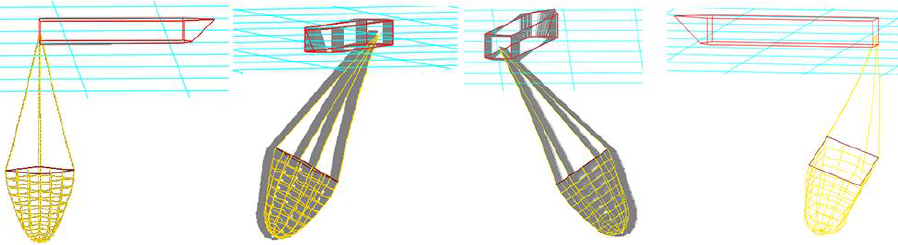
Figure 21. Shape changes of rigid truss trawl rotating towing under fixed turning radius at v = 2 m/s.